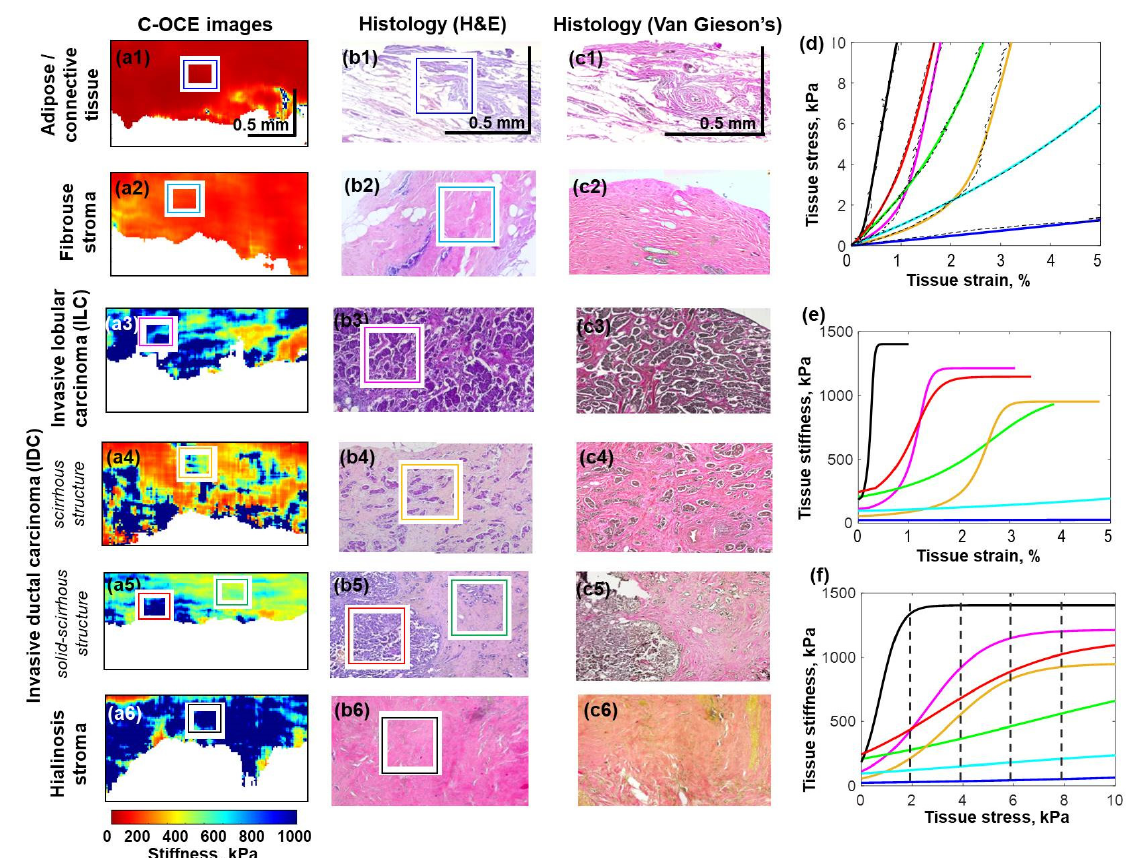
Figure 3. Illustration of different nonlinear elastic behaviors for seven different types of benign and malignant breast tissues, for which the representative zones are marked by different colored rectangles on histological and OCE images. Column ( a1 – a6 ) shows C-OCE images obtained for a standardized pressure of 4 kPa. Columns ( b1 – b6, c1 – c6 ) show histological H&E-stained and Van-Gieson-stained images, respectively. Typical stress–strain curves for the seven tissue zones marked by different colored rectangles are shown the same color curves in panel ( d ). ( e ) shows the corresponding derived stiffness–strain curves and ( f ) is for the stiffness–stress curves. Notice that malignant tissues (red, pink, orange, and green lines) tend to exhibit larger nonlinearity than benign tissues (blue and light-blue lines). Blue lines—adipose tissue with layers of connective tissue; light blue lines—fibrous stroma; red lines –agglomerates of tumor cells of IDC; orange lines—area of IDC, consisting of separate large clusters or nests of tumor cells distributed in the fibrous stroma; green lines—area of IDC, which is characterized by scattered individual tumor cells and dense fibrous stroma with hyalinosis of collagen fibers; pink lines—agglomerates of tumor cells of ILC, which is characterized by solid growth; black lines—large foci of hyalinosis. (Abbreviations: IDC—invasive ductal carcinoma; ILC—invasive lobular carcinoma).